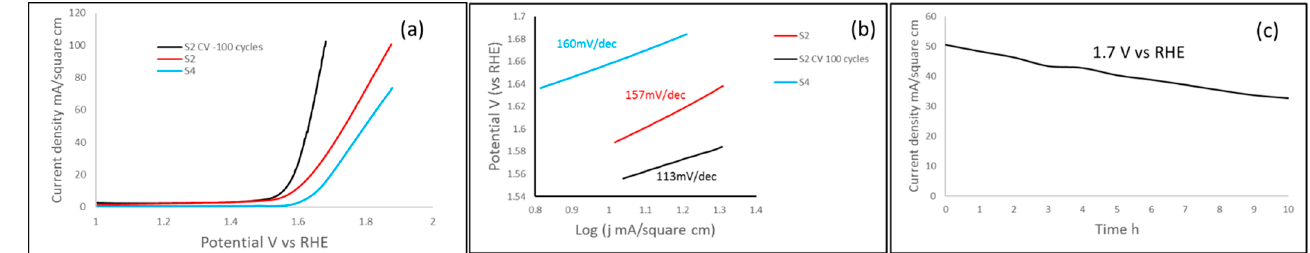
Figure 12. Electrochemical characterization of the as-sintered NiMnFeCu at various sintering con- ditions. ( a ) Linear sweep voltammetry curve at the scan rate of 5 mV s − 1 , ( b ) Tafel slopes derived from LSV curves, ( c ) chronoamperometry curve of the as-sintered NiMnFeCu (S2) at constant potential 1.7 V (vs. RHE).